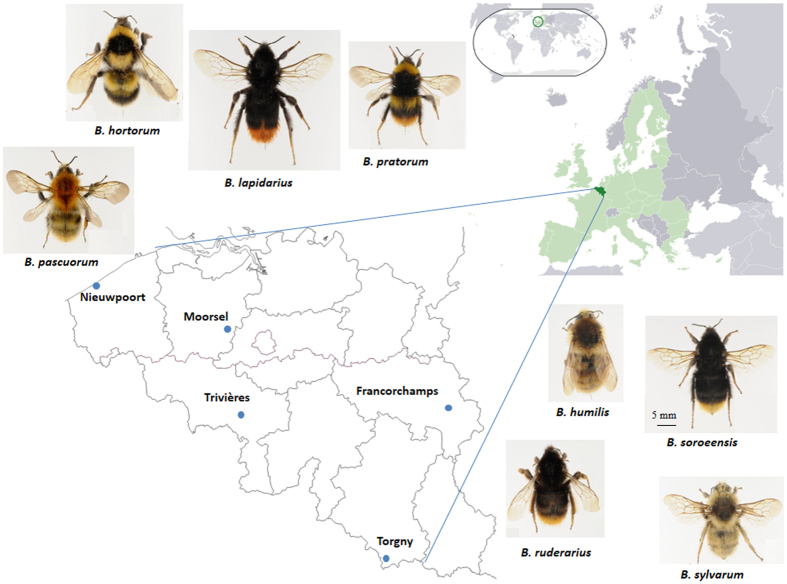
Overview of the bumblebee species sampled at five locations in Belgium.Specimens for each species were collected at the same five locations in Belgium in 1913–1915 and 2013–2015. Pictures of species are from Rasmont & Pauly60, and an adapted map of Belgium from http://www.d-maps.com/conditions.php?lang=en.